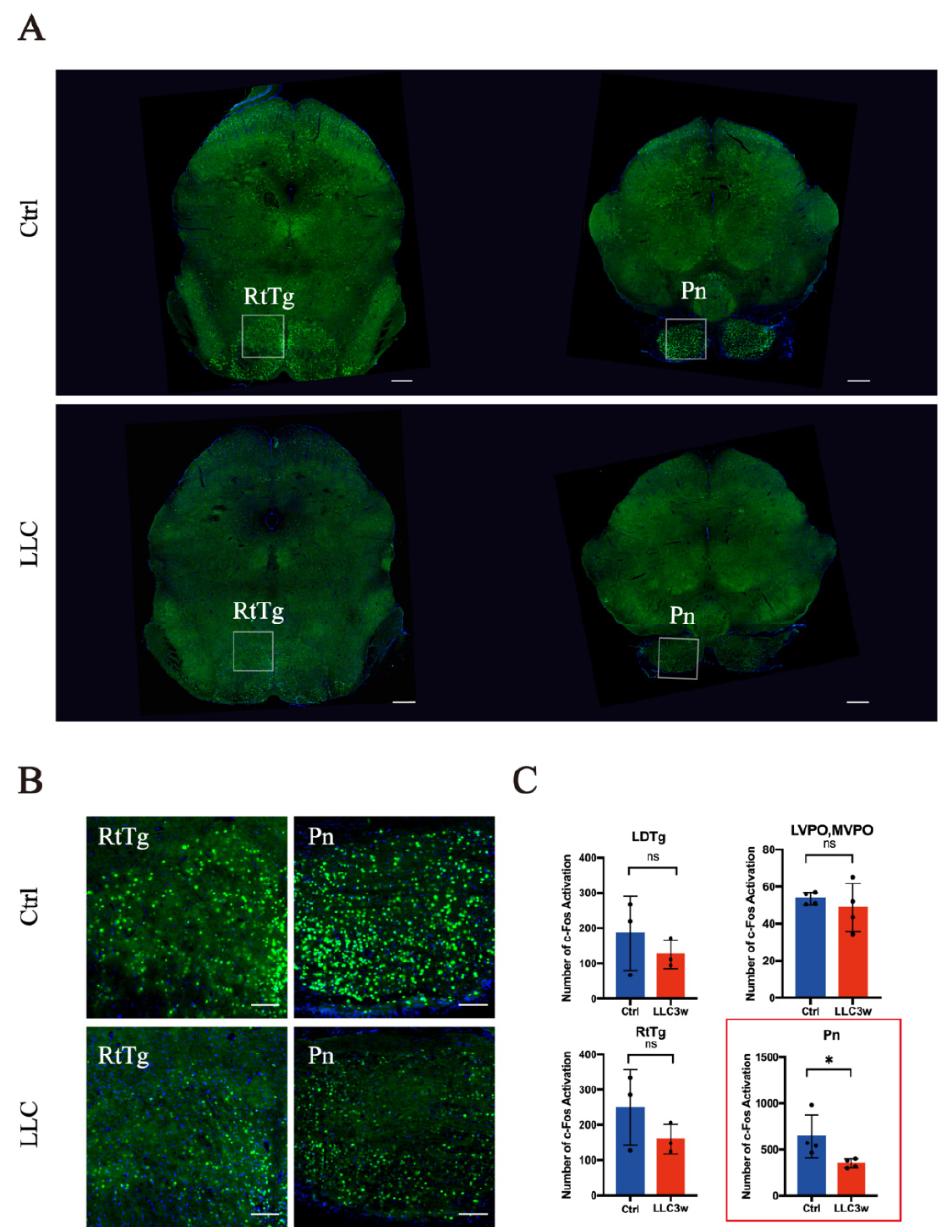
Figure 3. Overall c-Fos activation patterns in the pons. ( A ) Overview of coronal sections in the pons of LLC and control mice (scale bar = 400 µ m). ( B ) Enlarged photomicrographs of the pontine regions illustrate c-Fos activation in various brain structures of LLC and control mice (scale bar = 100 µ m). ( C ) Levels of c-Fos-activated neurons in LLC and control groups. There is a statically significant difference in Pn ( p < 0.05) between the LLC group and the control group ( p < 0.05), but there is no statically significant difference in LDTg, LVPO, MVPO, and RtTg between the LLC group and the control group ( p > 0.05). LDTg = laterodorsal tegmental nucleus, LVPO, MVPO = lateroventral periolivary nucleus, medioventral periolivary nucleus, RtTg = reticulotegmental nucleus of the pons, and Pn = pontine nuclei. “*” represents p < 0.05, “ns” represents no significant differences, red bars represent the experimental group (LLC3w) and blue bars represent the control group (Ctrl). Statistically different nuclei are represented in the red